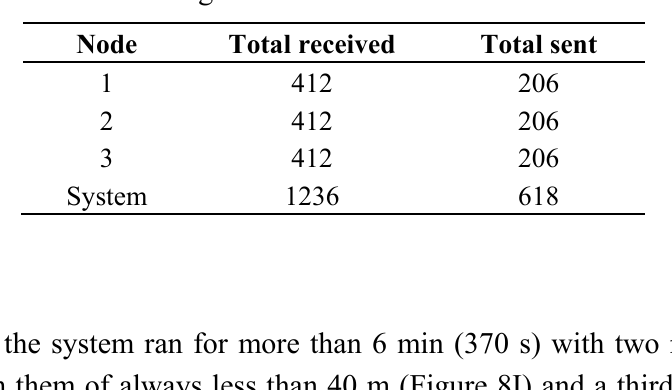
Table 6. Messages sent and received in the static